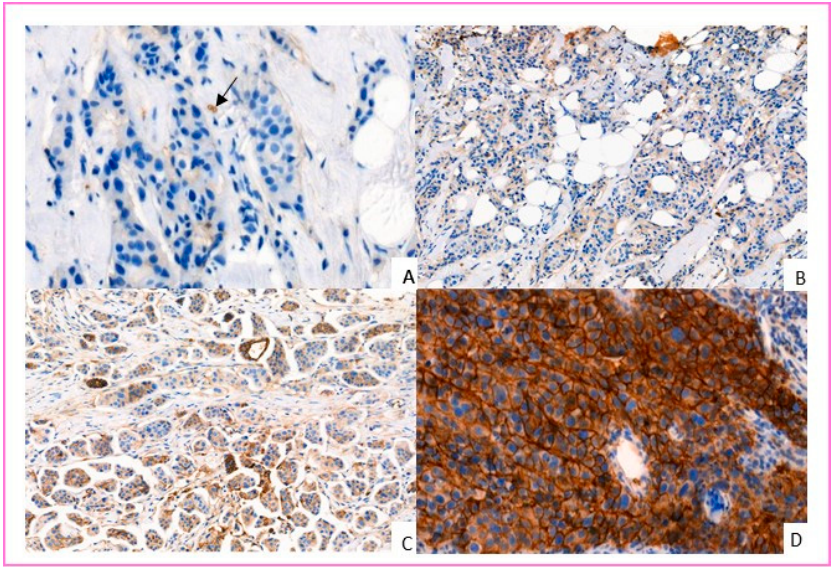
Figure 1. GLUT-1 immunohistochemistry (IHC) score in invasive breast carcinoma. ( A ) Score 0: No membrane staining by tumor cells (positive internal control: red blood cells—black arrow). ( B ) Score 1+: Membrane staining in some tumor cells (<10%). ( C ) Score 2+: membrane staining in ≥ 10% and <50% of tumor cells. ( D ) Score 3+: membrane staining in ≥ 50–100% of tumor cells (chicken wire appearance) (IHC GLUT-1, scanned slides, magnification ×330).